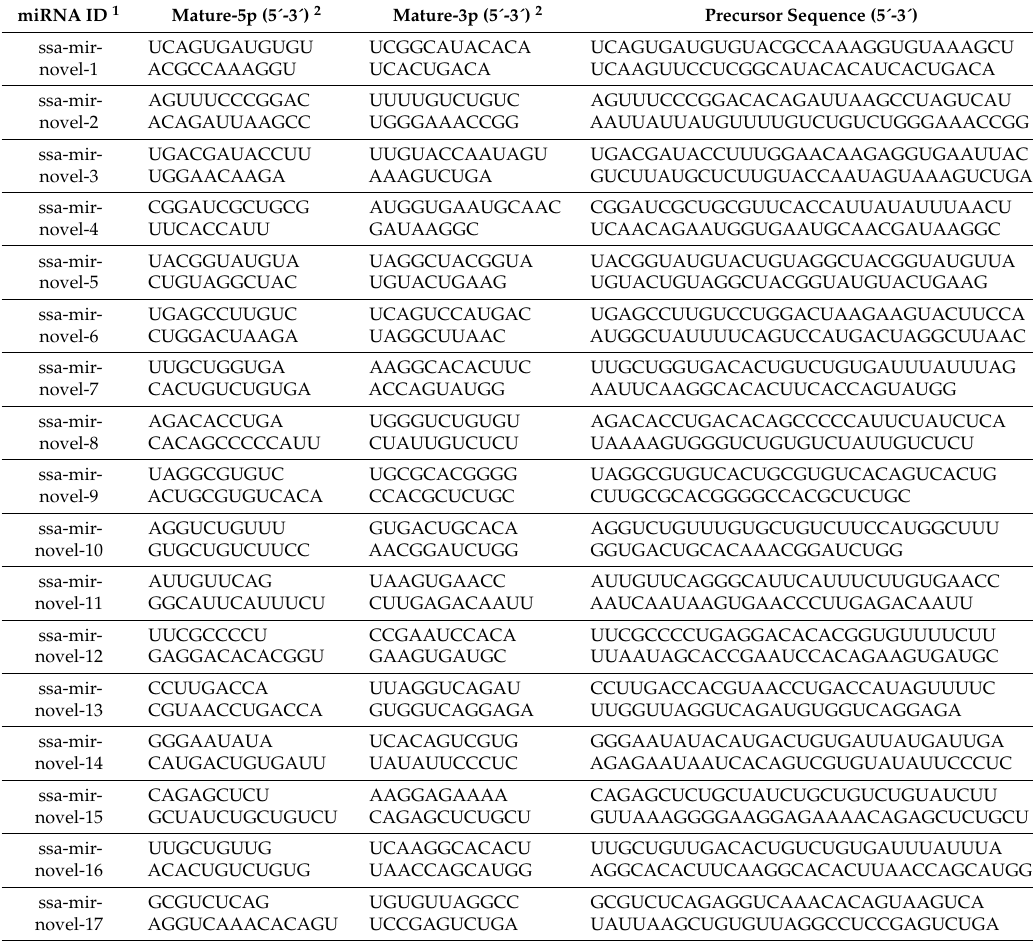
Table 1. Novel Atlantic salmon miRNAs identified in this